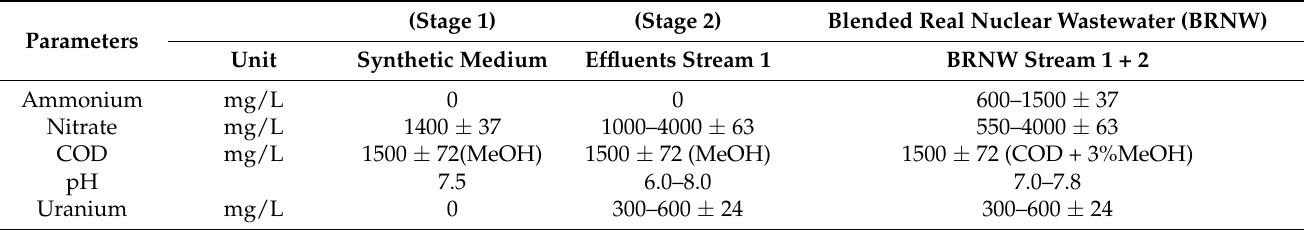
Table 1. Characteristics of the acclimation media for bacterial